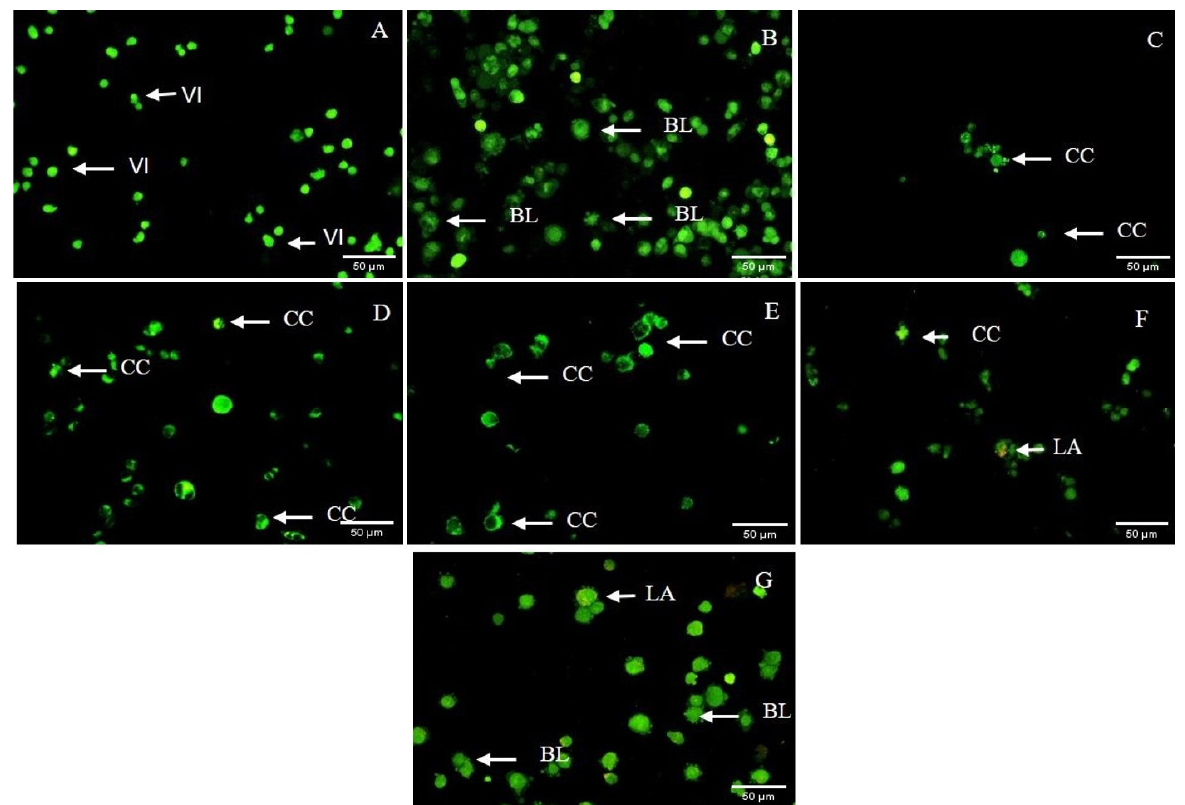
Figure 5. Fluorescence microscope AO/PI double staining of HRBE on SW-620 cells after being treated with 0 mg/mL, considered as negative control ( A ), 1.25 mg/mL ( B ), 2.5 mg/mL ( C ), 5 mg/mL ( D ) and 10 mg/mL ( E ) for 72 h compared to positive control groups treated with 0.05 mg/mL mitomycin C treatment ( F ) and doxorubicin (0.116 mg/mL) ( G ). VI: viable cell; blebbing of the cell membrane; CC: chromatin condensation; LA: late apoptosis.